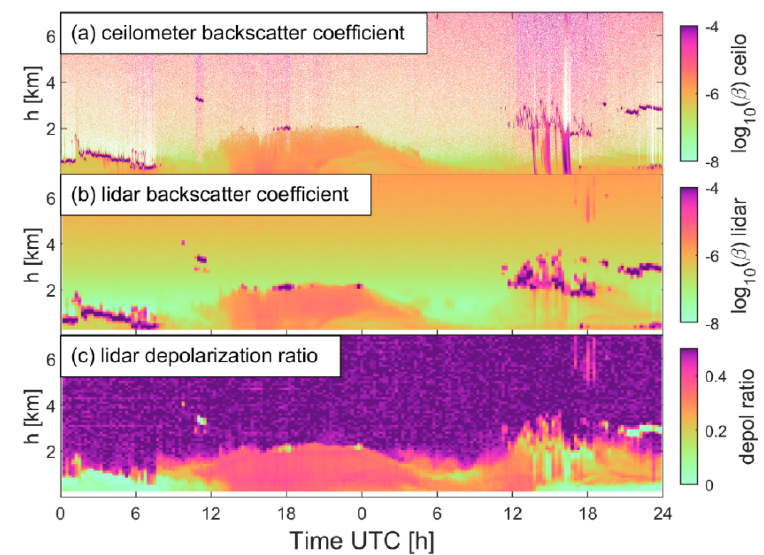
Figure 7. Time height cross-section of the backscatter coefficient from the ceilometer ( a ) and the Doppler lidar ( b ) as well as the lidar depolarization ratio ( c ) in Reykjavík, for 48 h, from 00:00 UTC, 14 June to 24:00 UTC, 15 June, 2019. The lidar data is an average of 15 min, and the ceilometer data is not averaged. Note that the lidar measurements start at 200 m above the surface.